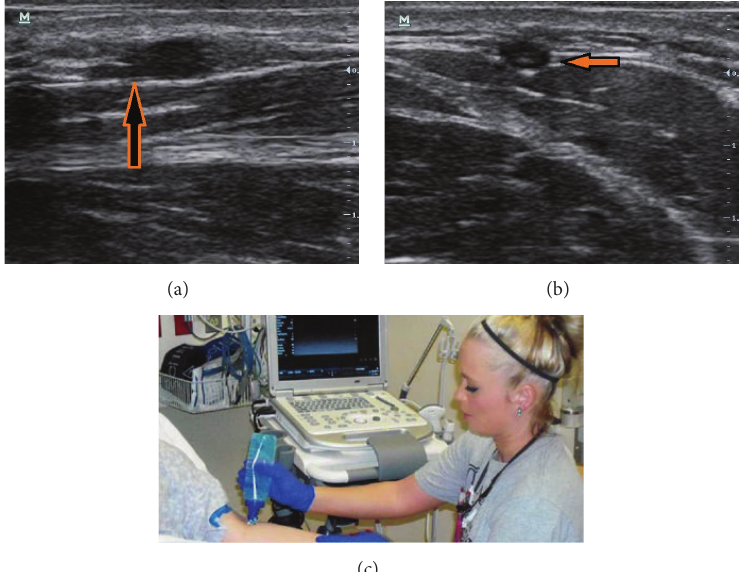
Figure 1: (a) Catheter tip (hyperechoic or white) shown accessing a vein (hypoechoic or black square) in the oblique access; the catheter is highlighted in by the orange arrow. (b) A catheter tip (hyperechoic or white) shown accessing the peripheral vein (hypoechoic or black circle) circle in the coronal plane delineated by the orange arrow. (c) A nurse preparing to perform US guided IV access notes the location of the ultrasound machine to allow for line of site of both the machine and the